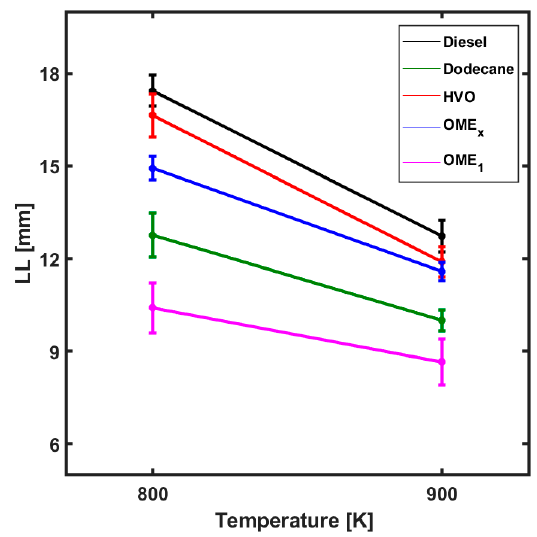
Figure 4. Liquid length for 15% O 2 and 1500 bar of injection pressure.